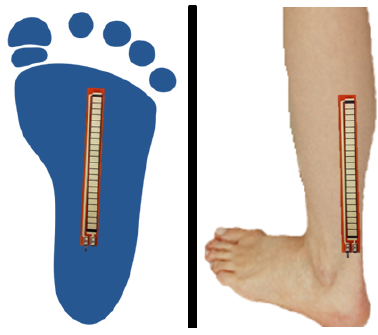
Figure 5. Placement of the angle sensors.